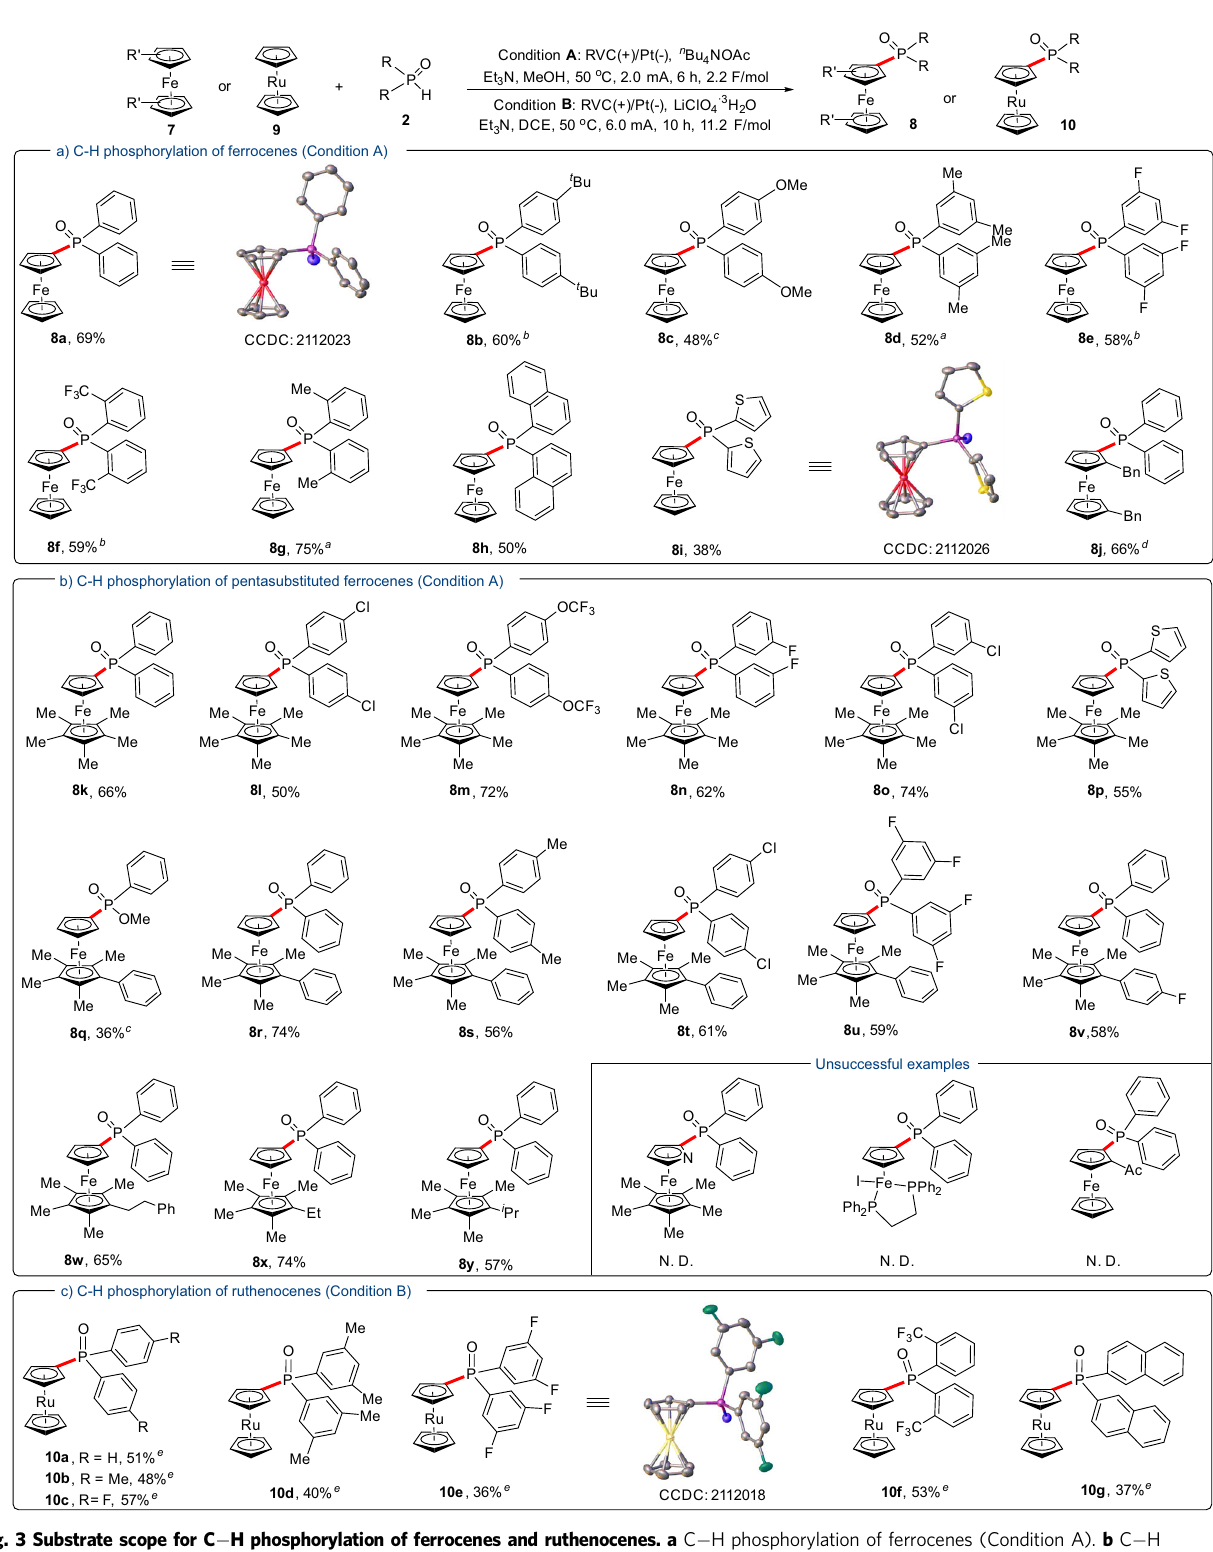
Fig. 3 Substrate scope for C − H phosphorylation of ferrocenes and ruthenocenes. a C − H phosphorylation of ferrocenes (Condition A). b C − H phosphorylation of pentasubstituted ferrocenes (Condition A). c C − H phosphorylation of ruthenocenes (Condition B). a Reaction with 2.0mA, 12h (4.5F/mol).